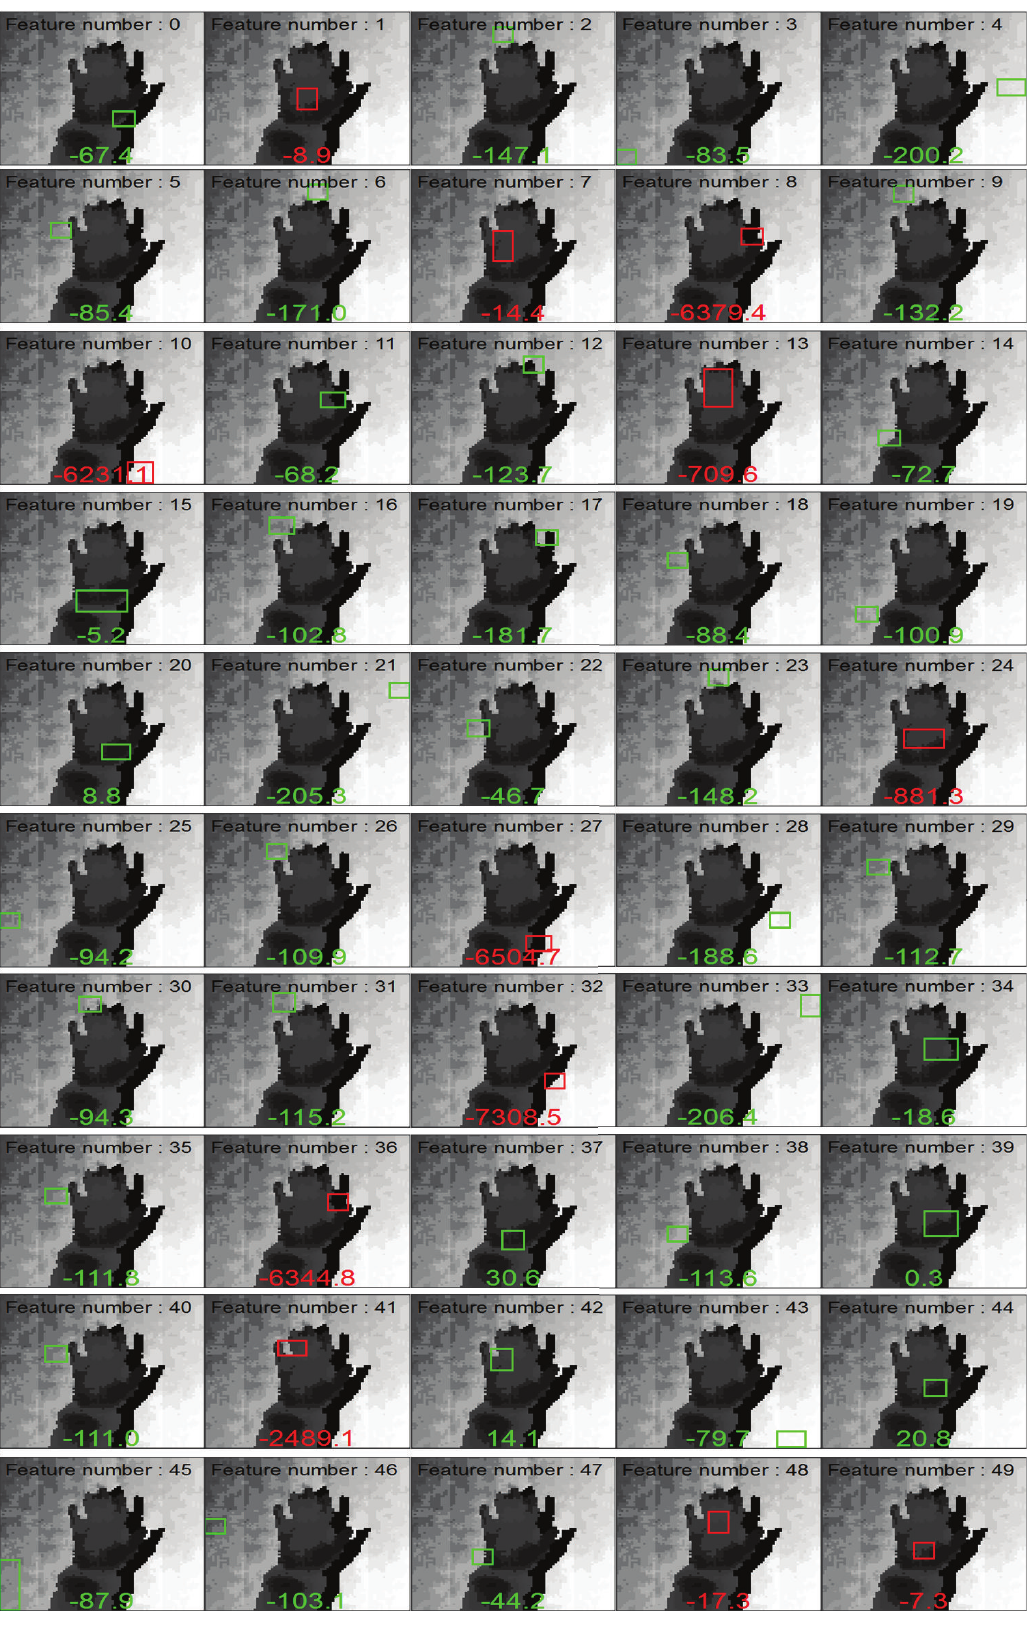
Figure 12: Fifty selected